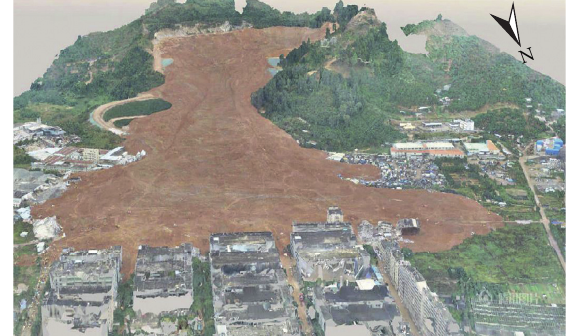
Figure 8: Shenzhen flowslide. Source: Aerial image form